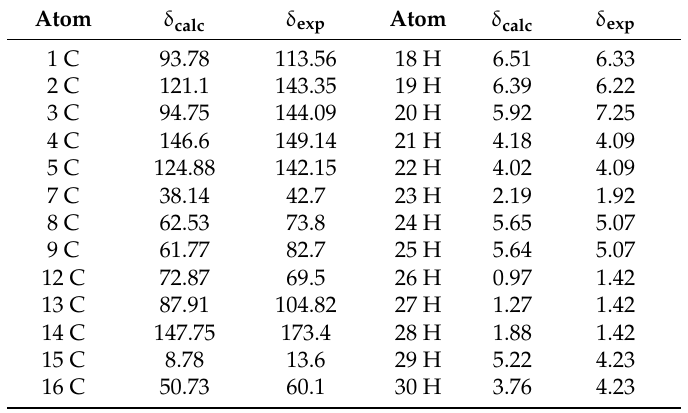
Figure 6. The correlation graphs between the calculated and experimental chemical shifts compound 5 . Table 7. Calculated and experimental NMR chemical shifts of compound 6